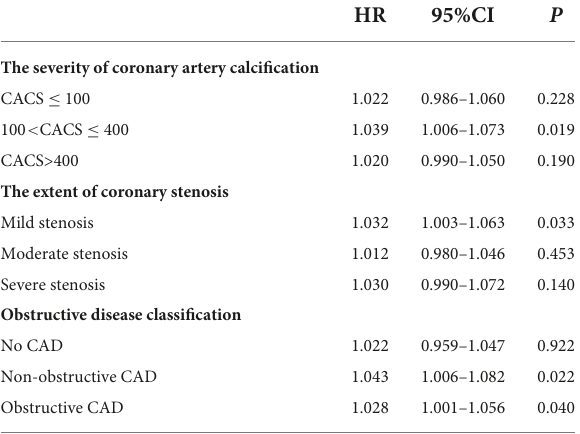
TABLE 5 PDW/HDL-C predicting MACCEs among different severity of coronary artery